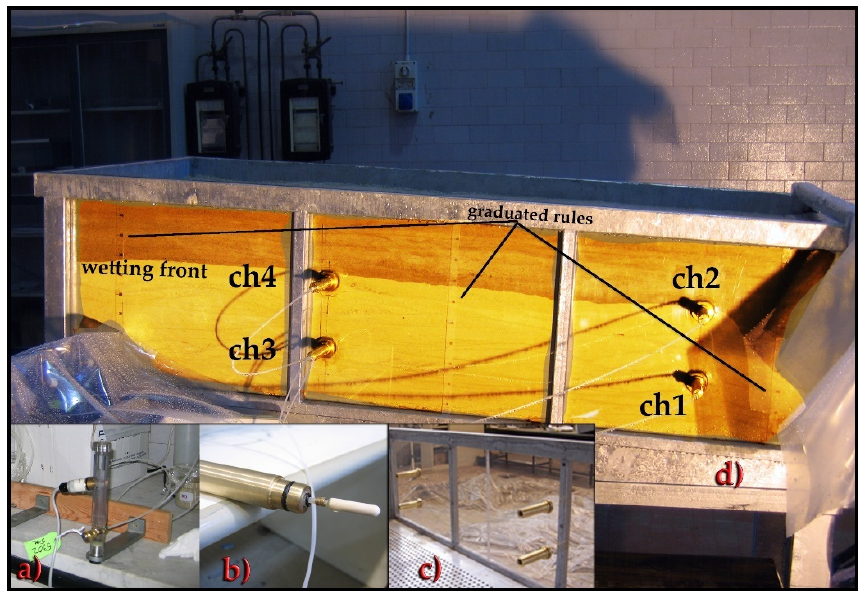
Figure 5. Physical model apparatus: ( a ) remote positioning tensiometer; ( b ) handles for the insertion of ceramic tips; ( c ) tubes for the tensiometers ceramic tips handles; ( d ) transparent tank side with three graduated rules for the tracing of the wetting front and channel map of the tensiometers in the data acquisition system.